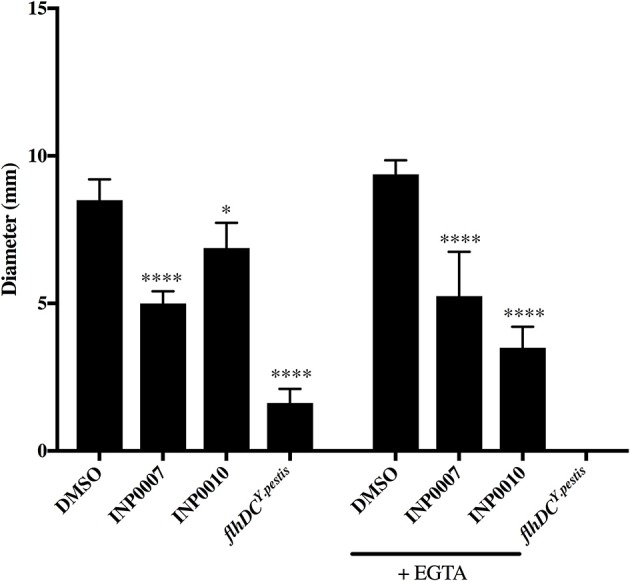
INP0007 and INP0010 inhibit Y. pseudotuberculosis motility. Y. pseudotuberculosis wildtype or the non-motile flhDCY.pestis mutant were spotted onto motility agar containing the 50 μM compounds or the equivalent volume of DMSO and allowed to grow for ~24 h. Average swimming diameter of the colony was measured from three biological replicates ± standard deviation and statistical significance is represented comparing compounds relative to the DMSO control. ****P < 0.0001, *P < 0.03 (one way ANOVA with Dunnett's post-hoc test).